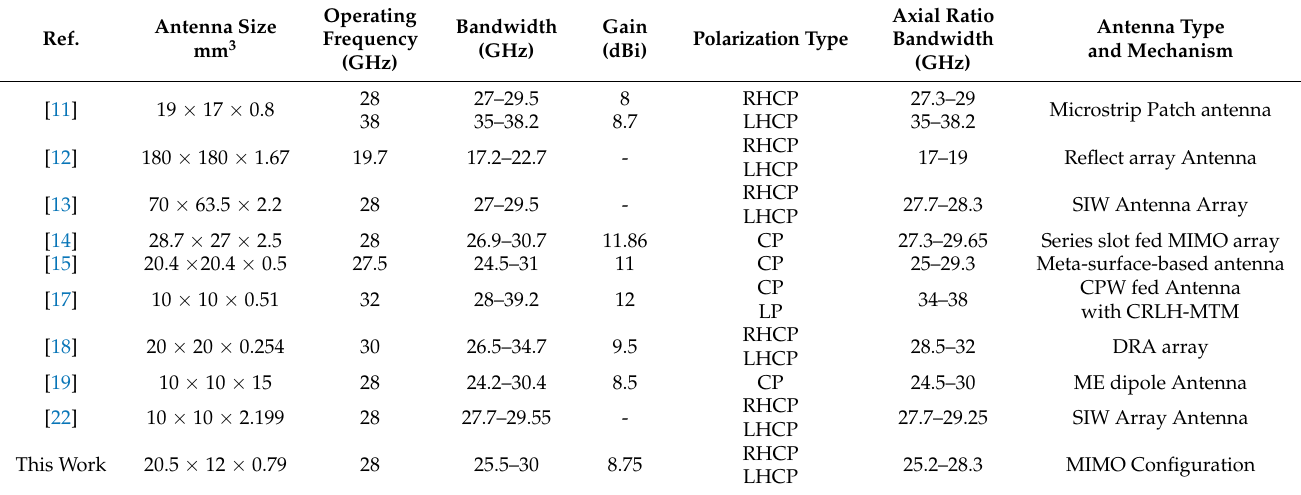
Table 2. Comparison of proposed study with